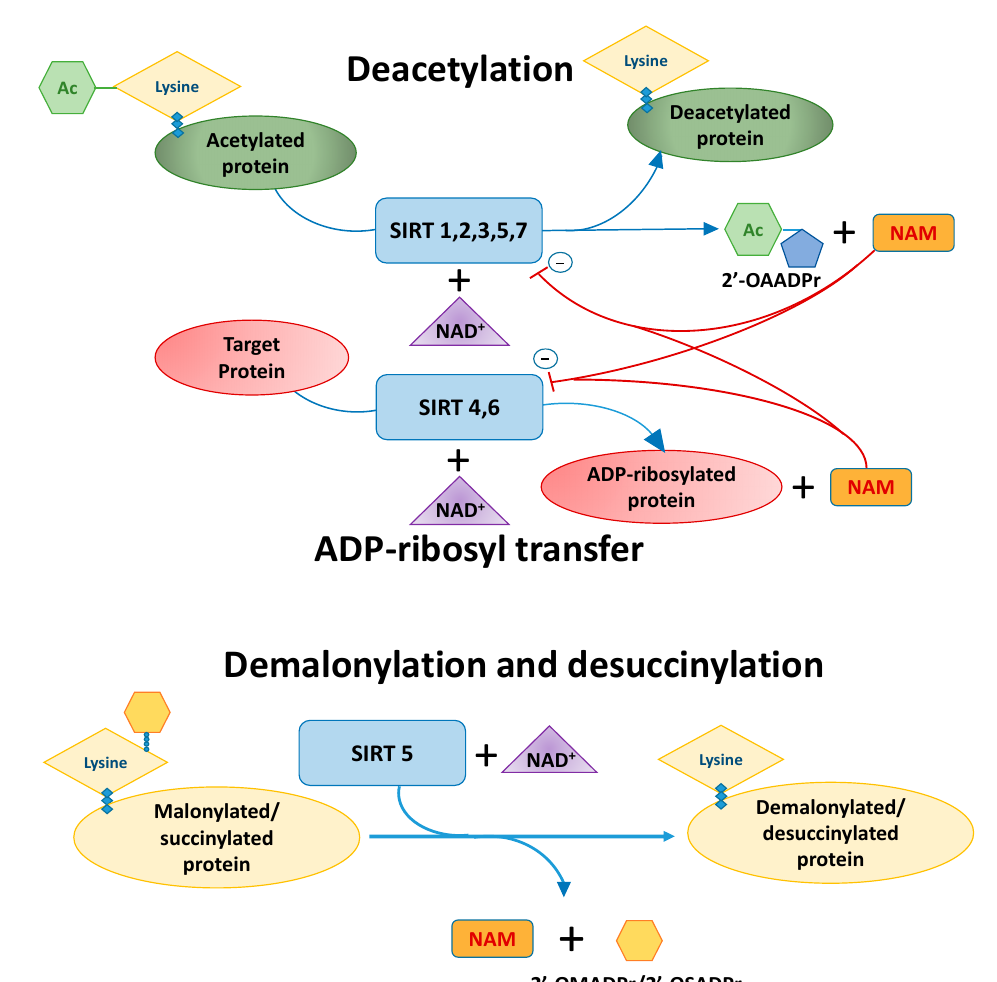
Figure 1. Enzymatic activity of the SIRTs. NAD + is a substrate for all SIRTs in reaction of nicotinamide (NAM) production. In the deacylation reaction, NAD + receives the acetyl (Ac) group from the protein. The adenine dinucleotide moiety from NAD + is linked to various residues on the target protein in ADP-ribosyl transfer. SIRT1, 2, 3, 5 and 7 show the lysine deacetylation activity of target proteins in which the NAD + coenzyme is used to produce NAM and 2 (cid:48) -O-acetyl-ADP-ribose (2 (cid:48) -OAADPr). SIRT4 exhibits only ADP-ribosyl transferase activity, and NAD + is used as a donor of the ADP-ribose group for target proteins. ADP-ribosyl transferase activity shares with SIRT6. SIRT5 uses NAD + as a cofactor in the demalonylation and desuccinylation of target proteins, generating NAM and 2’-O-malonyl-ADP-ribose (2 (cid:48) -OMADPr) and 2 (cid:48) -O-succinyl-ADP-ribose (2 (cid:48) -OSADPr), respectively. Modification based on Morigi et al. [4,5].